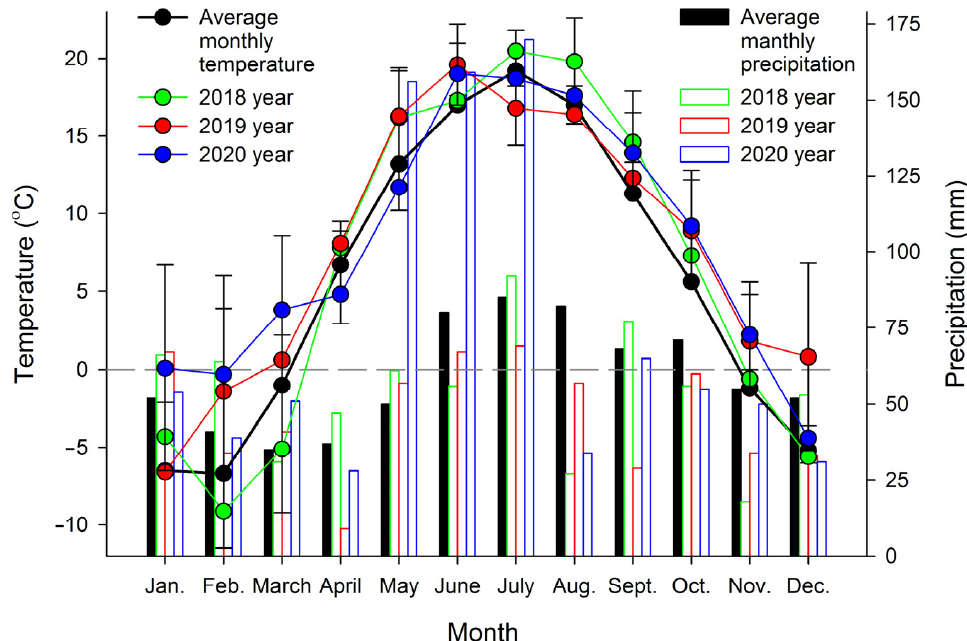
Figure 1. Monthly averages of temperature and precipitation at the Asplenium scolopendrium collection site during 2018–2020. Values are presented as the means ± SEMs.